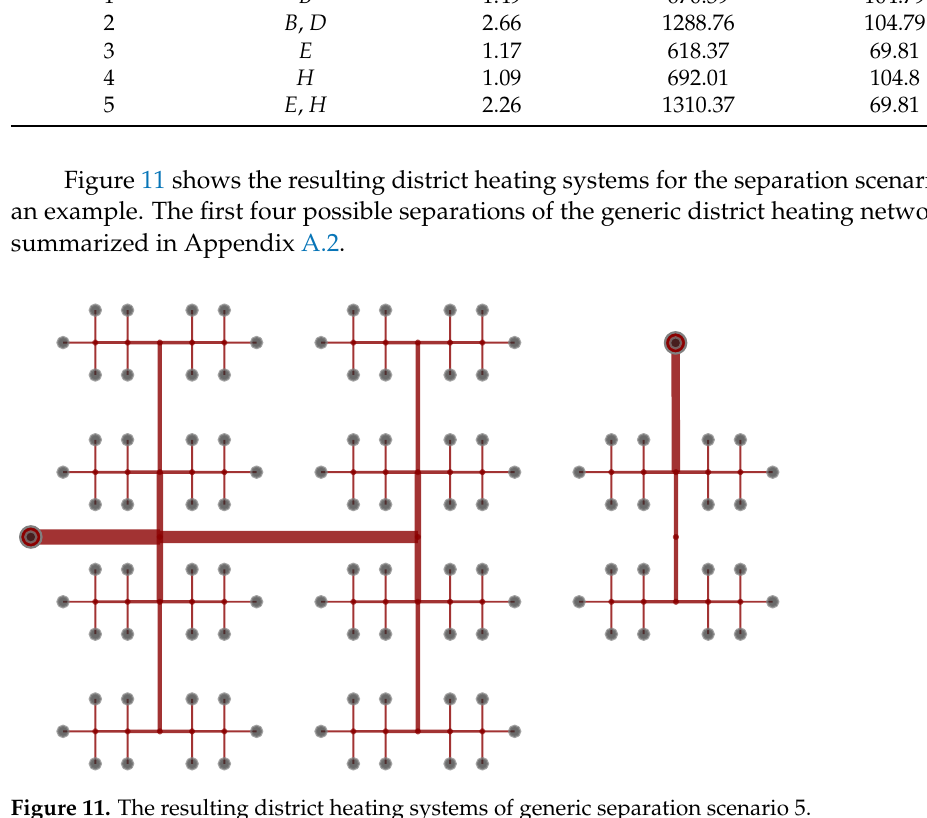
Figure 11. The resulting district heating systems of generic separation scenario